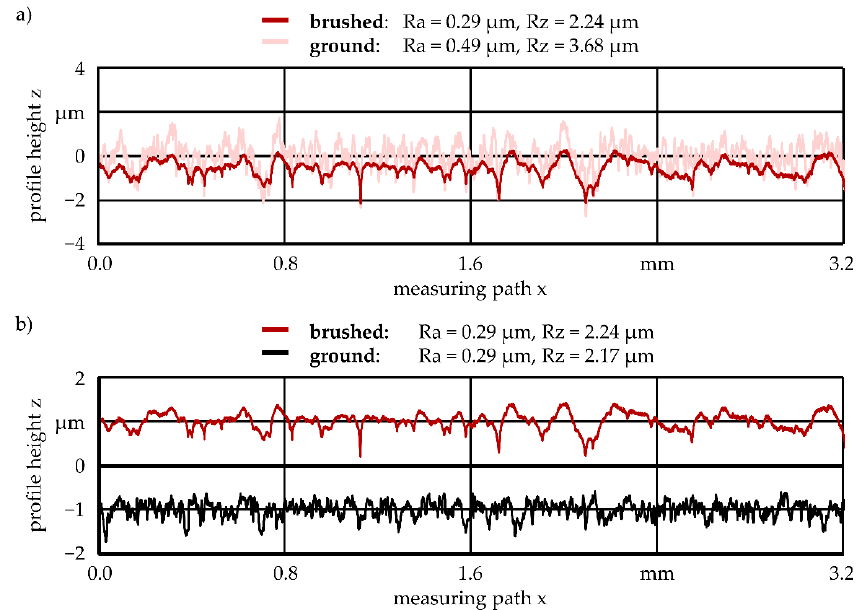
Figure 13. Qualitative consideration of the roughness profiles of ground and brushed surfaces; ( a ) Comparison of the initial roughness and the brushed surface; ( b ) Comparison of a brushed and a ground surface with similar roughness parameters.